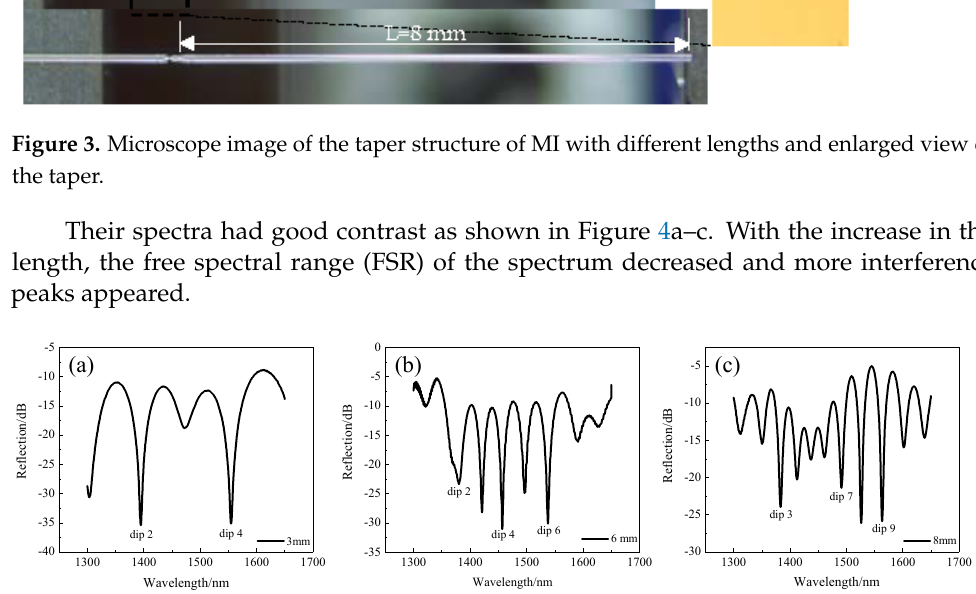
Figure 4. Reflection spectra of the MI structure with different lengths (L). ( a ) L = 3 mm; ( b ) L = 6 mm; ( c ) L = 8 mm.